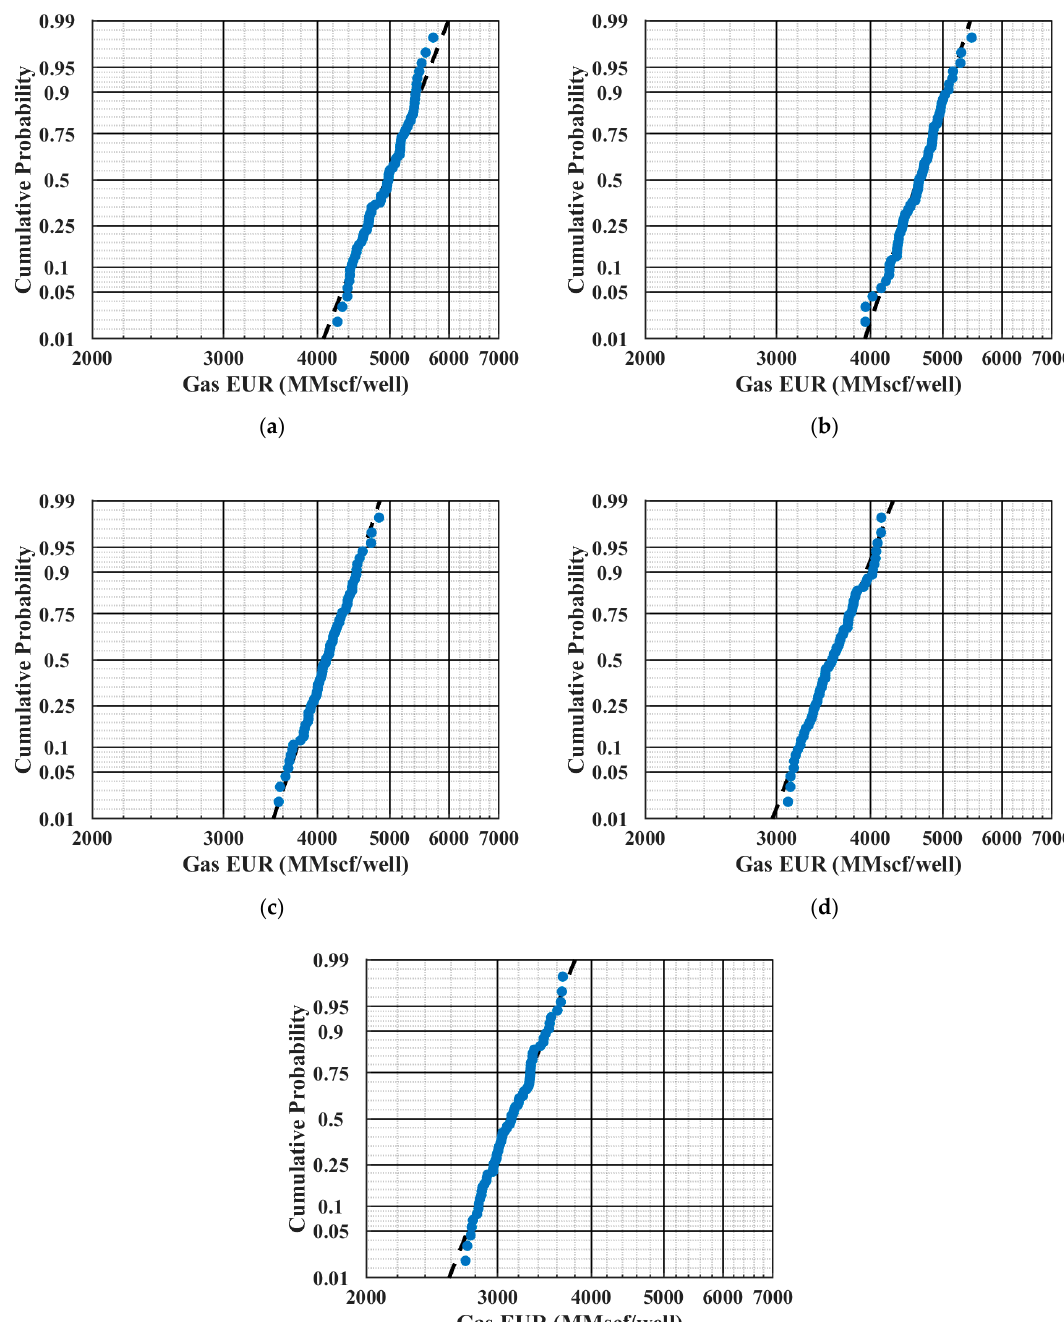
Figure 8. Estimated ultimate gas recovery per well for the different well spacing scenarios (EUR represents estimated ultimate recovery and MMscf represents million standard cubic feet): ( a ) the two-well spacing of 472 m (1550 ft); ( b ) the three-well spacing of 315 m (1033 ft); ( c ) the four-well spacing of 236 m (775 ft); ( d ) five-well spacing of 189 m (620 ft); and ( e ) the six-well spacing of 158 m (517 ft).